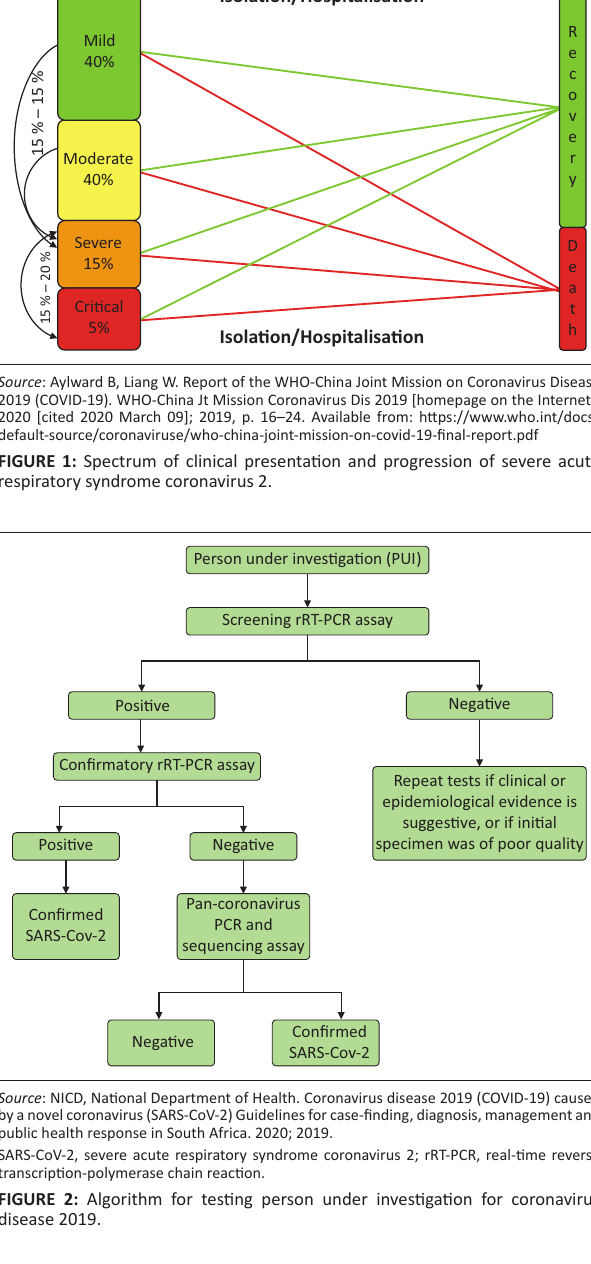
FIGURE 2: Algorithm for testing person under investigation for coronavirus disease 2019.